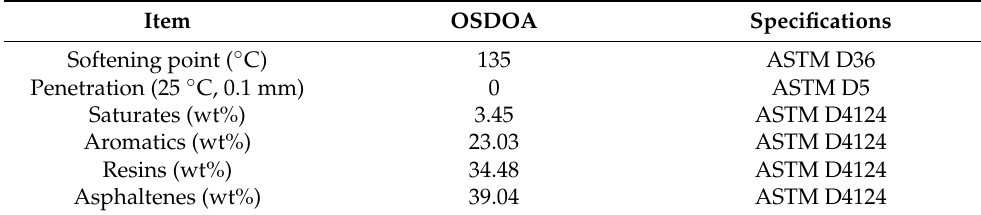
Table 3. Physical and chemical properties of